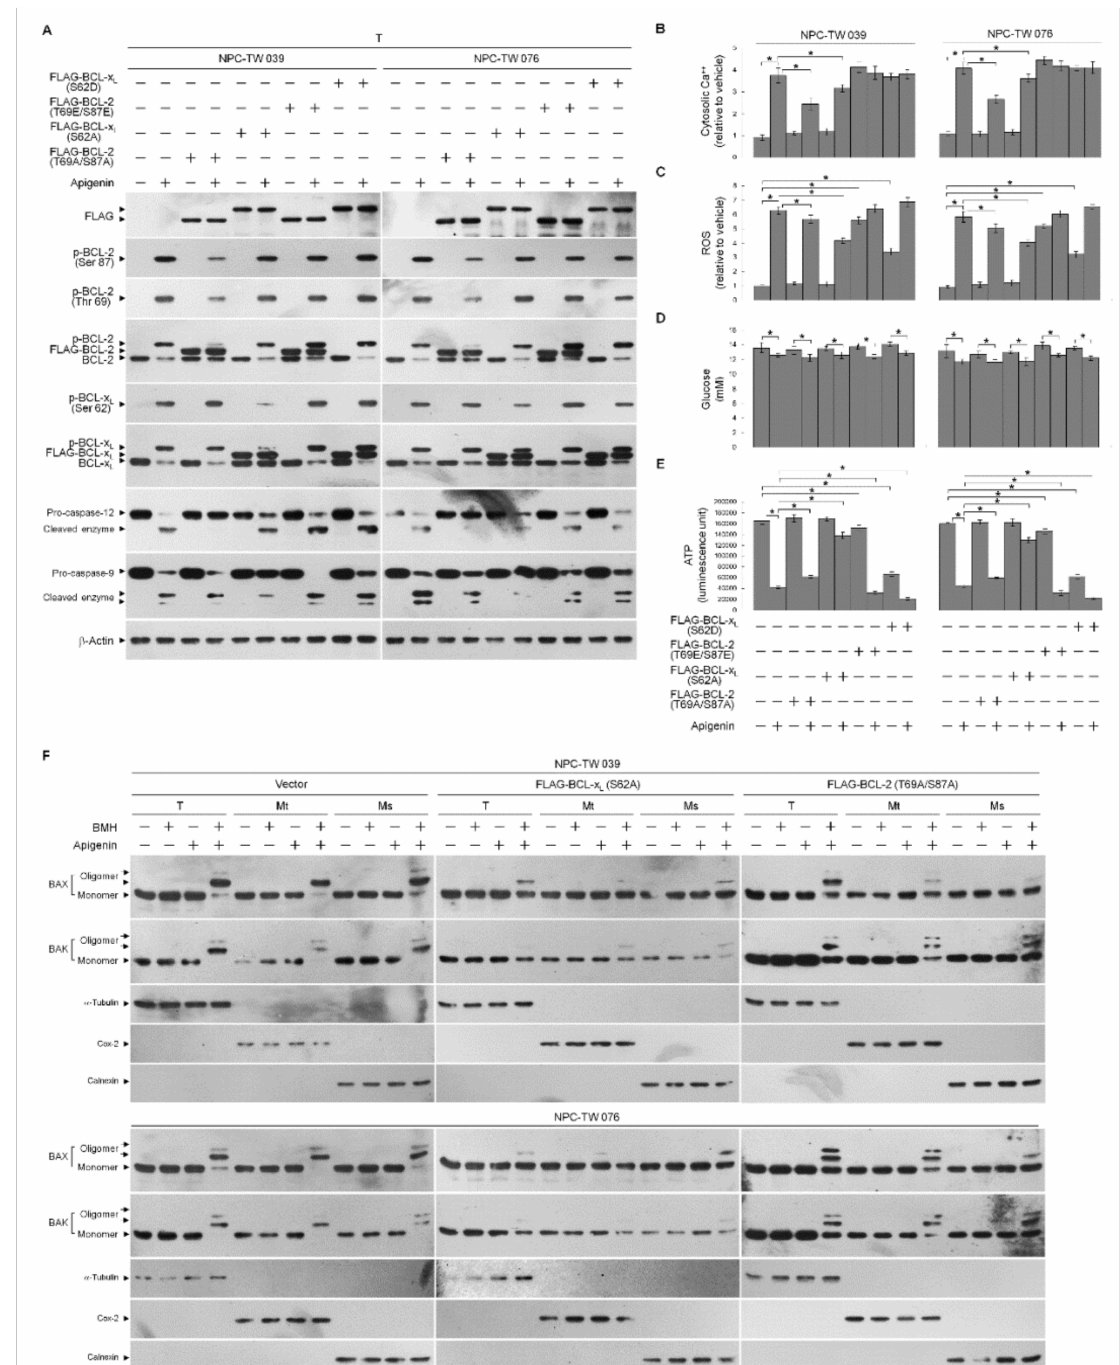
Figure 2. Apigenin-induced B cell lymphoma 2 (BCL-2) (Thr 69 and Ser 87)/BCL-2/B-cell lymphoma-extra large (BCL-x L ) (Ser 62) phosphorylation contribute to endoplasmic reticulum (ER)–mitochondria oligomerization of Bcl-2-associated